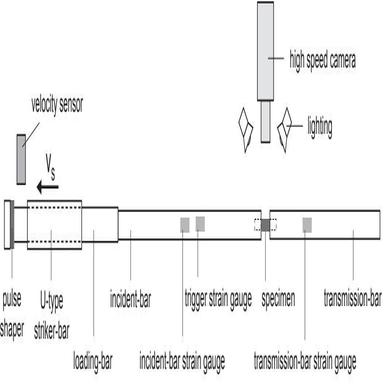
Photo-mechanical setup for dynamic tensile tests (after \).